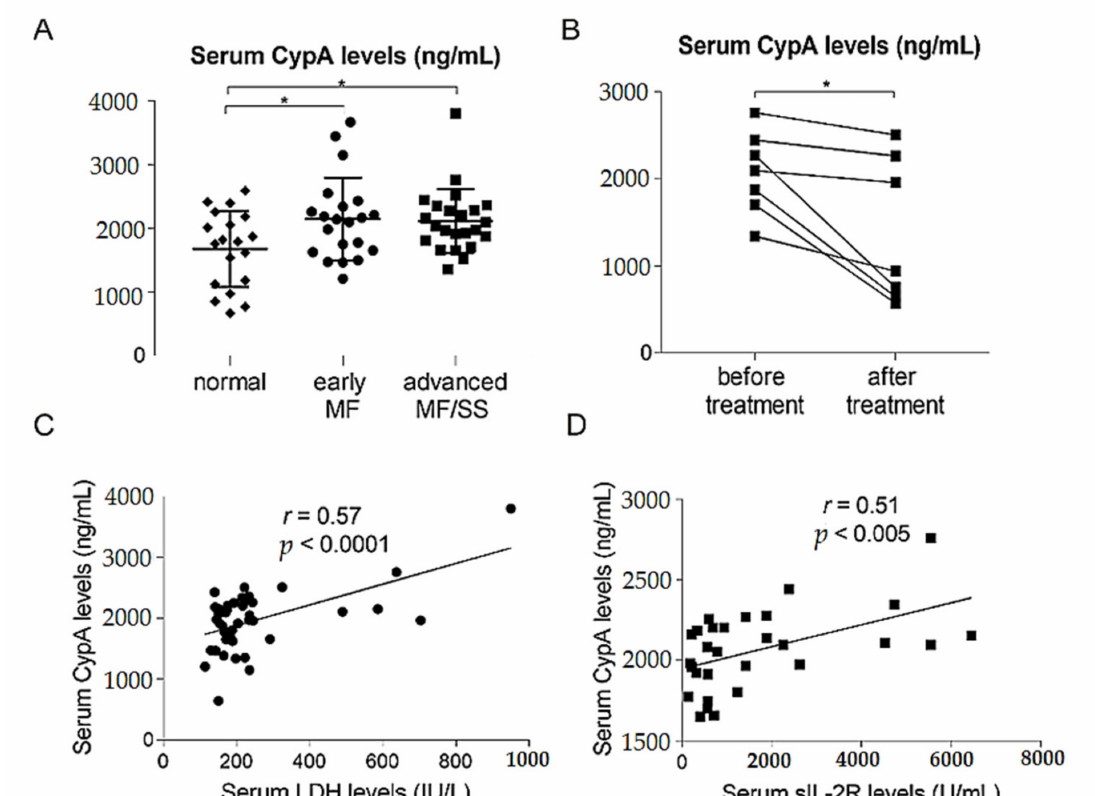
Figure 3. Serum cyclophilin A (CypA) levels are increased and correlated with disease severity markers in patients with mycosis fungoides (MF) and S é zary syndrome (SS). ( A ) Serum CypA levels in early MF patients ( n = 21), advanced MF/SS patients ( n = 23), and healthy control ( n = 19). ( B ) Serum CypA levels in MF/SS patients ( n = 7) before and after treatment. ( C , D ) Correlations between serum CypA levels and serum lactate dehydrogenase (LDH) levels ( n = 44) ( C ) and serum soluble IL-2 receptor (sIL-2R) levels ( n = 29) ( D ) in MF/SS patients. The measured values from individual patients are plotted with dots. Bars represent mean ± standard deviation. * p <